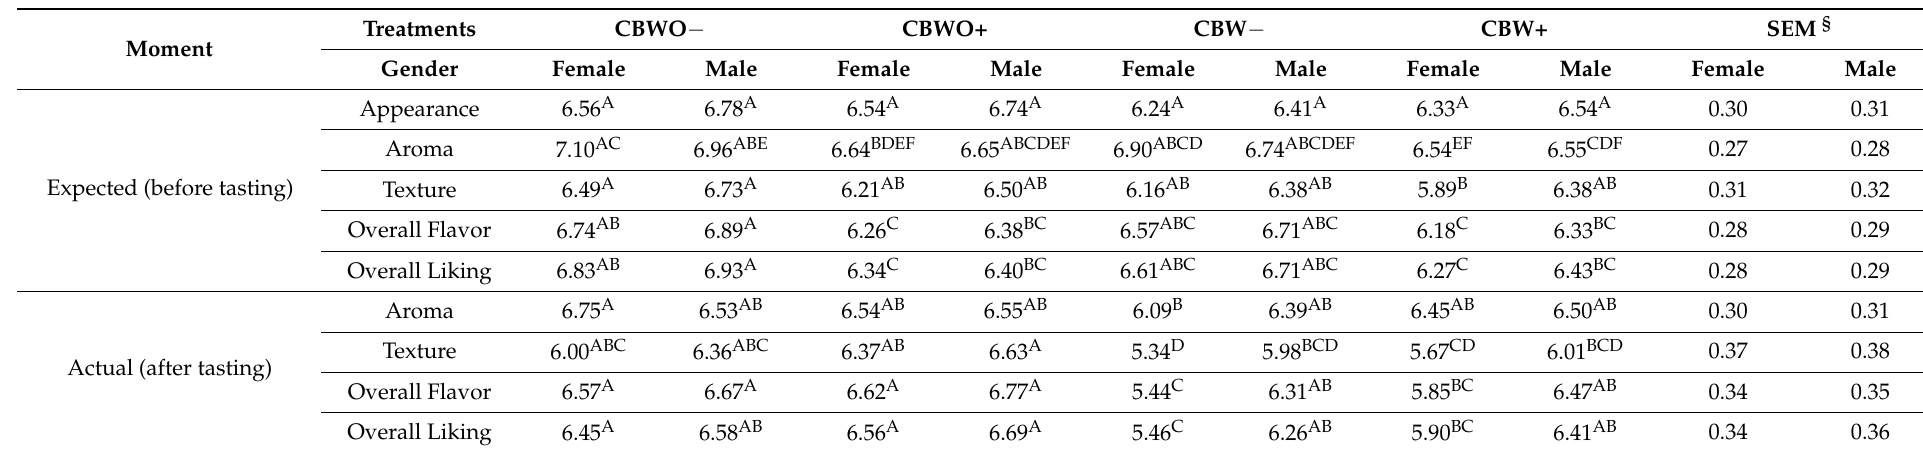
Table 3. Sensory acceptability † of treatments ‡ by